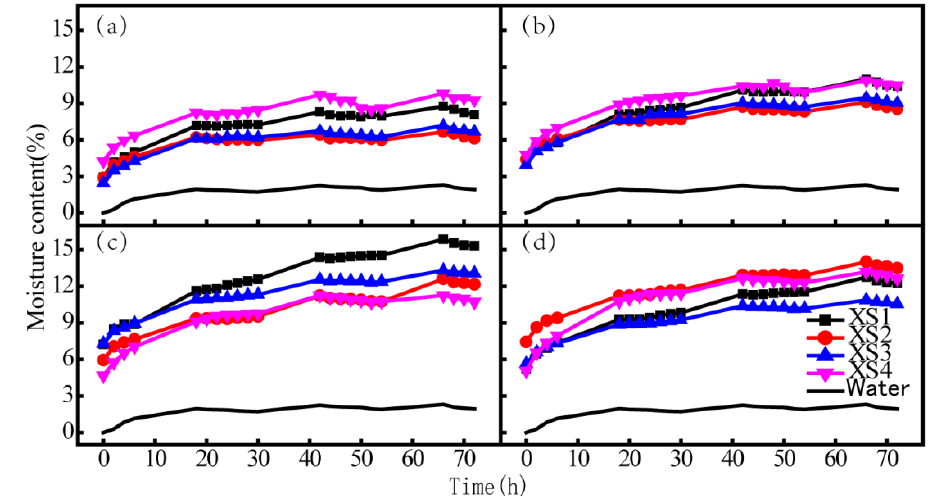
Figure 2. ( a – d ) Variation curves of moisture content rate of hygroscopic agent monomers with concentrations of 6%, 8%, 10%, and 12%, respectively.